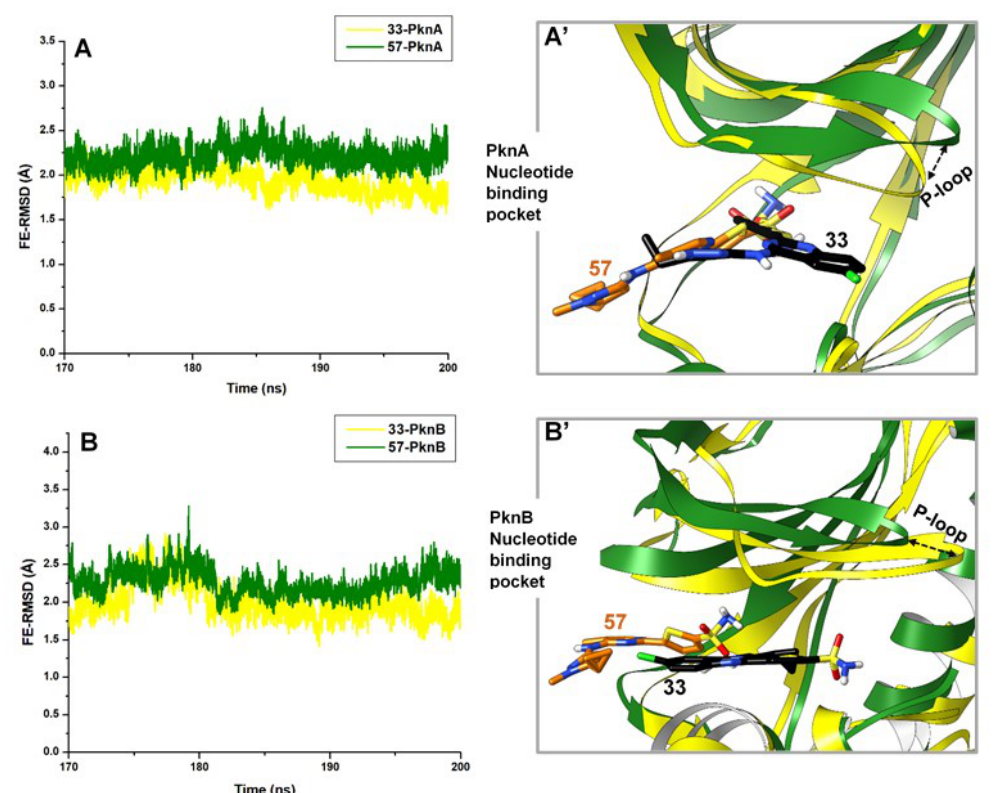
Figure 3. FE-RMSD plot showing systematic C α deviations as induced by 33 and 57 at the nucleotide binding pockets of ( A ). PknA and ( B ). PknB. Orientations of the compounds with respect to their binding activities are shown in ( A’ , B’ ). Also captured are the alterations at the NBP P-loop induced by the binding of compound 33 .